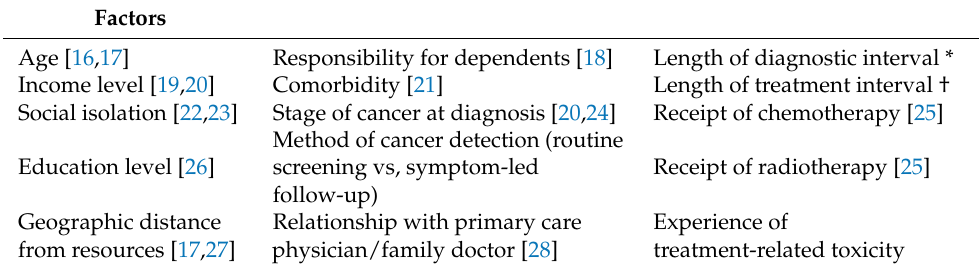
Table 1. Factors included in study interview